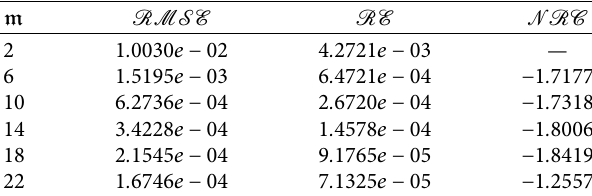
Table 1: RMSE , RE , and NRC for diferent m for Example 1.